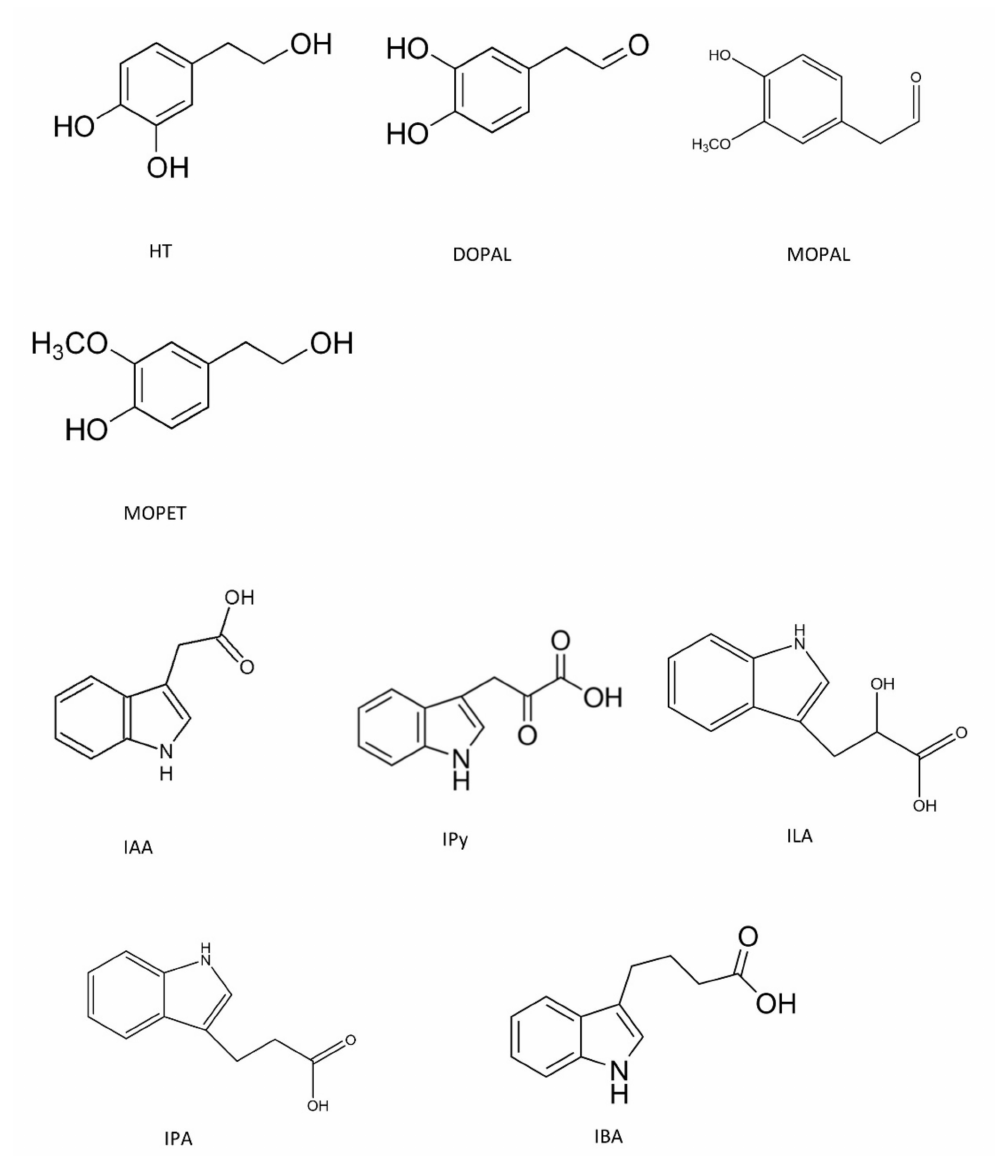
Figure 1. Chemical structure of HT metabolites and indolic compounds under